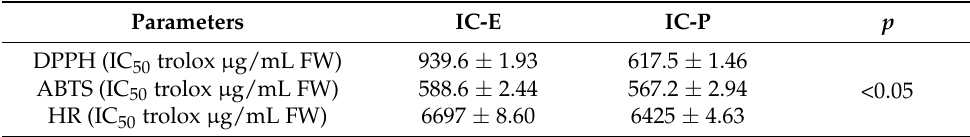
Table 1. In vitro antioxidant of IC extracts. Parameters